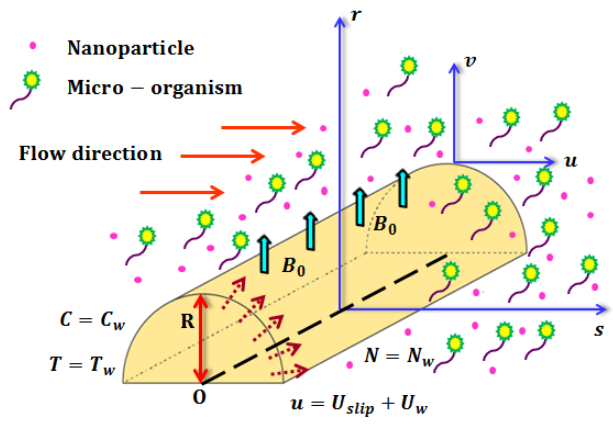
Figure 1. Flow configuration.